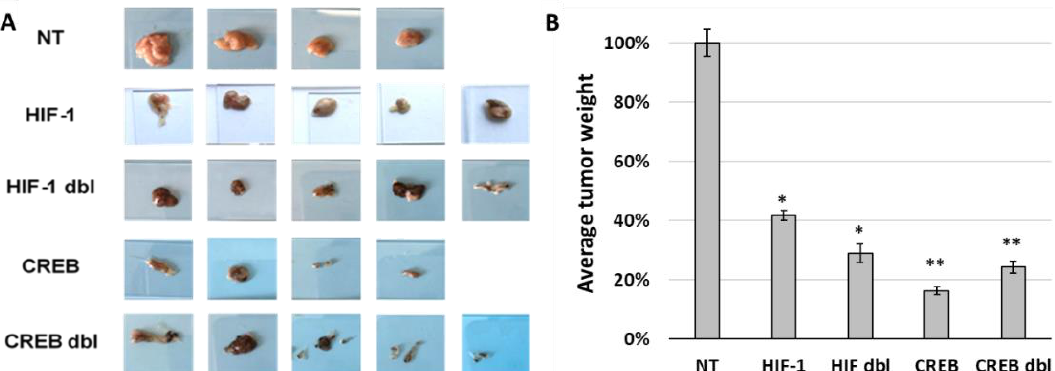
Figure 6. Effect of knockdown of either CREB or HIF-1 on tumor growth. Uveal melanoma tumors excised on day 35 post implantation (Figure 5) were photographed ( A ). The tumors were weighed and the average weight of each group is presented relative to the average weight of UM tumors infected with vACE-NT ( B ). Comparing each group to NT ( t test) demonstrated a statistically significant decrease in tumor size for all the groups (* p < 0.5; ** p < 0.01).